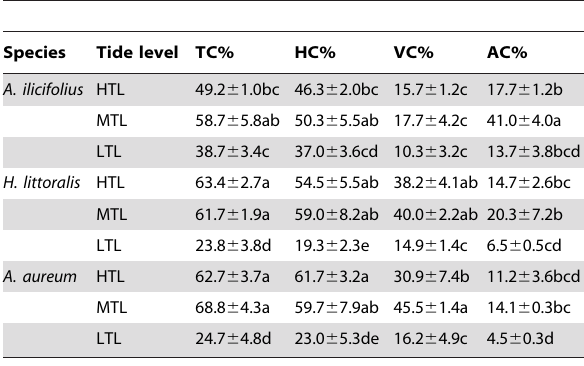
Table 2. AMF colonization intensity in each of three mangrove species at the high, middle and low tide